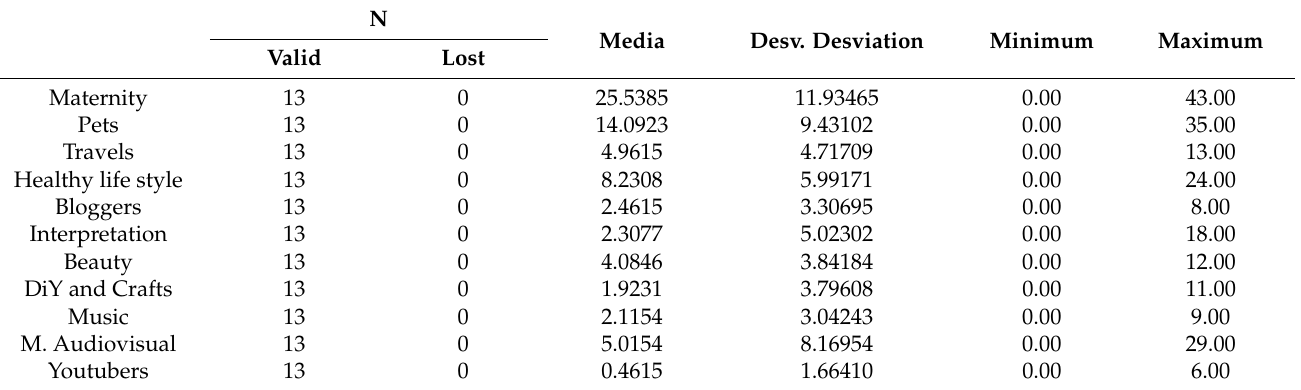
Table 3. Descriptive statistics (Audience